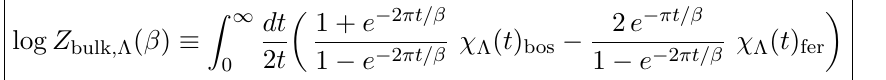
Figure 7 . ρ G, Λ ( ω ) for dS d +1 scalar of mass m 2 = ( d Pauli-Villars regularizations (2.15). Faint part is unphysical UV regime ω √ appearing at ω = ν 2 + n Λ 2 are related to quasinormal mode resonances (appendix